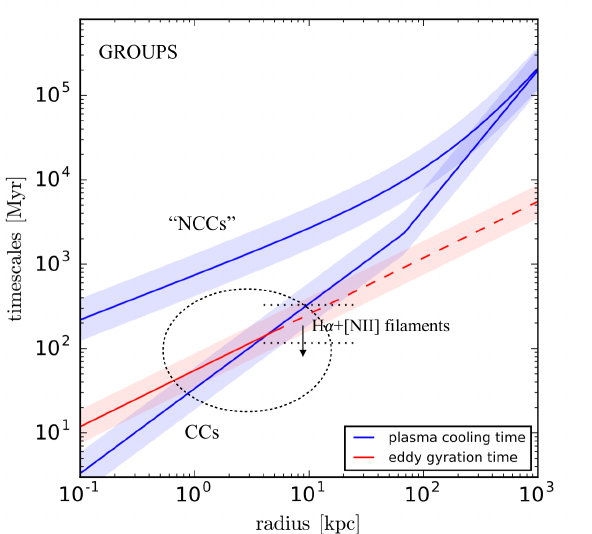
Figure 11. The average cooling time and turbulence eddy time profiles in the IGrM (with 90% confidence scatter bands), the latter constrained mainly via optical/IR telescopes (figure reproduced from Gaspari et al. [165]; group sub-sample). The dotted circle marks the size of the condensed warm nebular emission, which matches the C ≡ t cool / t eddy ∼ 1 turbulent TI